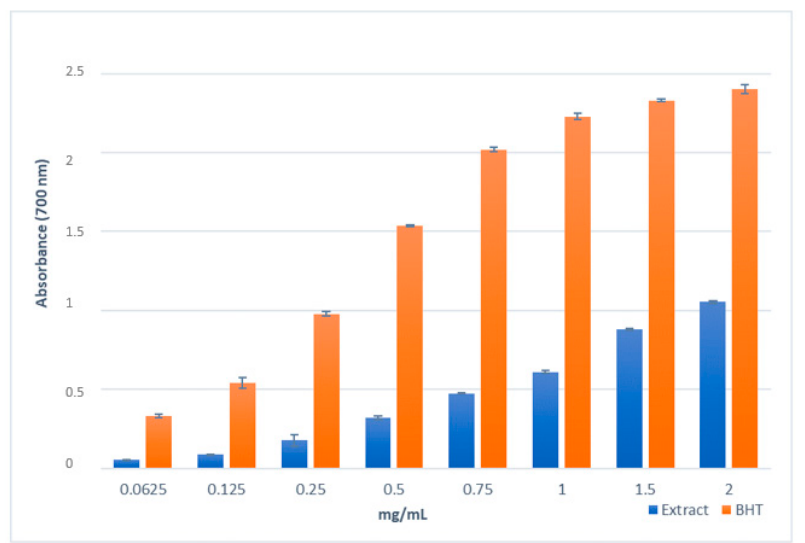
Figure 3. Reducing power of the methanol extract obtained from biomass of in vitro shoot culture of Scutellaria brevibracteata subsp. subvelutina (3.0 mg/L BAP and 1.0 mg/L NAA). Evaluated by spec- trophotometric detection of the Fe 3+ -Fe 2+ reducing method. Values are expressed as the mean ± SD ( n = 3).